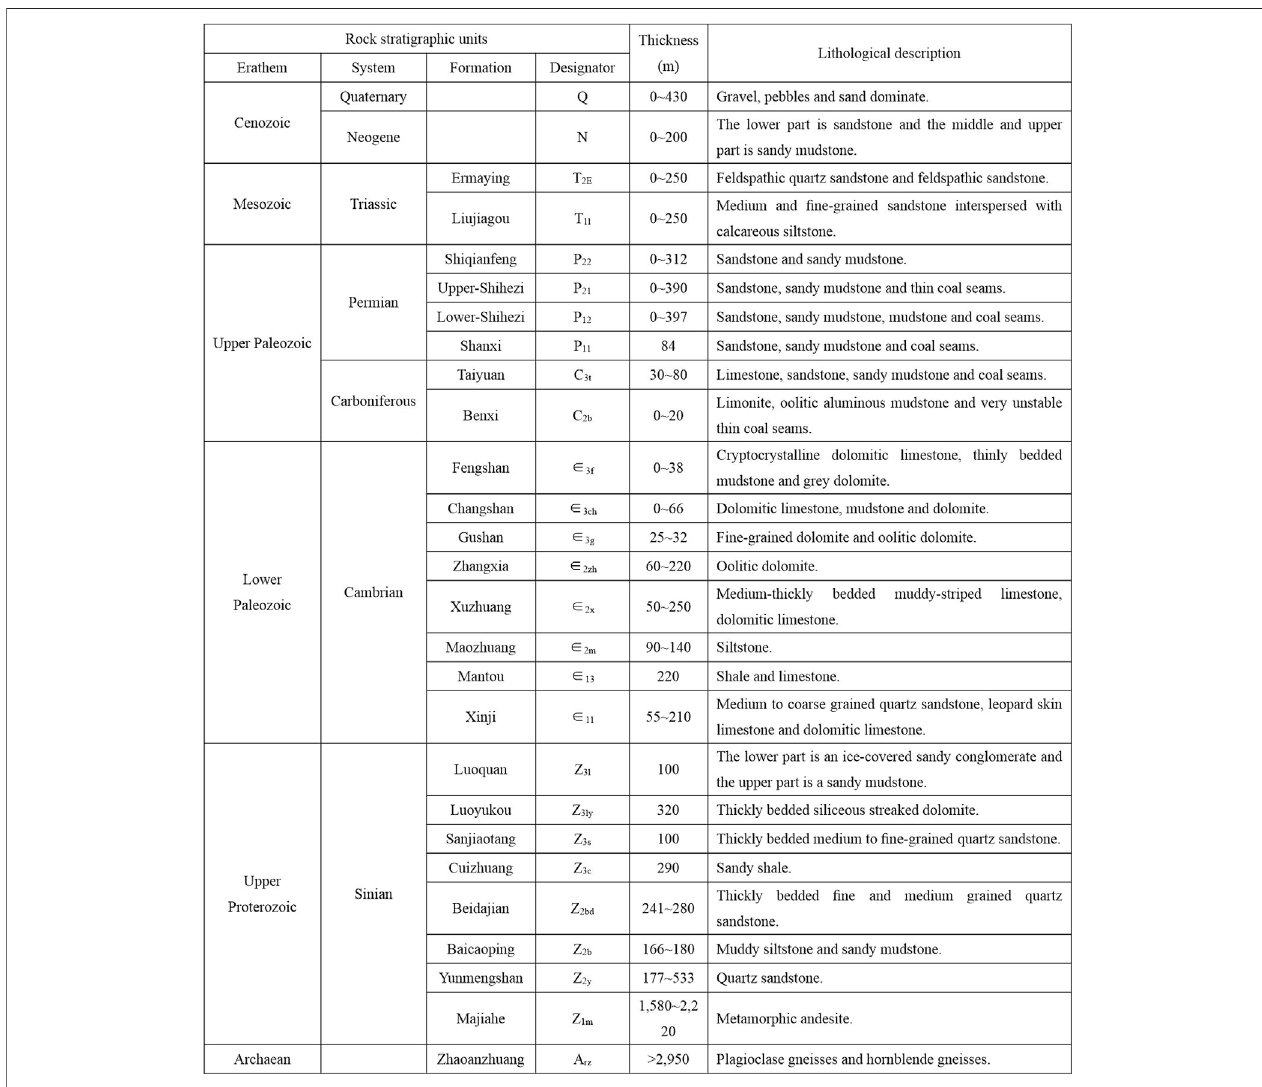
FIGURE 2 | Histogram of stratum